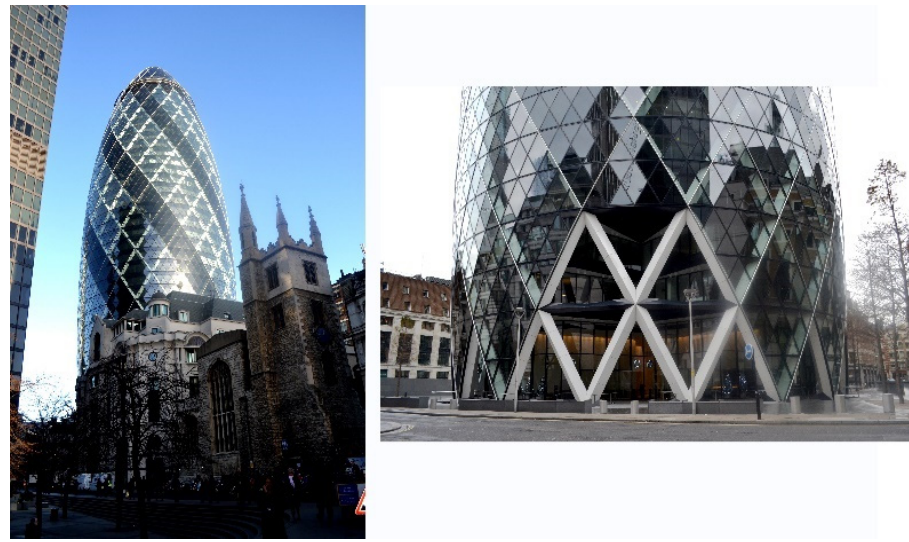
Figure 15. Swiss Re (or Gherkin) Building (2004) in London, UK. (Photo by K. Al-Kodmany).